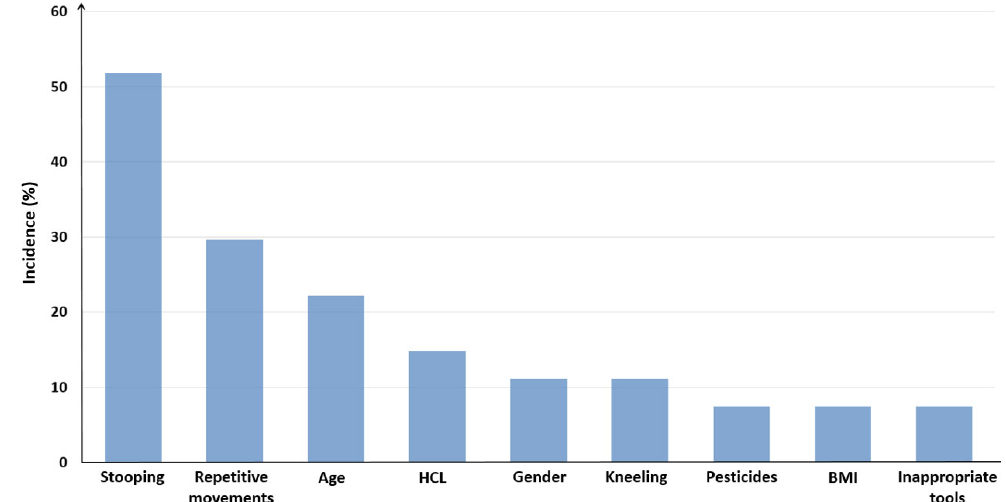
Figure 6. Incidence (%) of the main identified risk factors causing MSDs. The abbreviations HCL and BMI correspond to Heavy Carrying and Lifting and Body Mass Index, respectively.